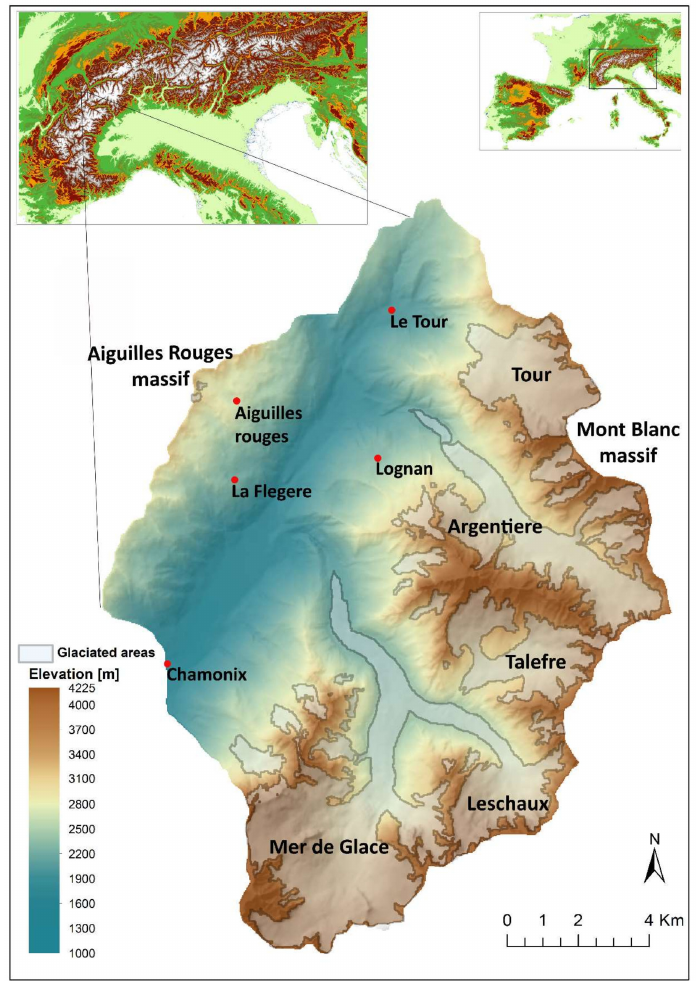
Figure 1. Upper Arve catchment study area. The white shaded area shows the extent of the glaciers in 2012 (Gardent et al., 2014). The inner maps show various magnifications of the Alps and the location of the Arve valley within the mountain range. The red points show the position of the five M é t é o-France stations located in the study